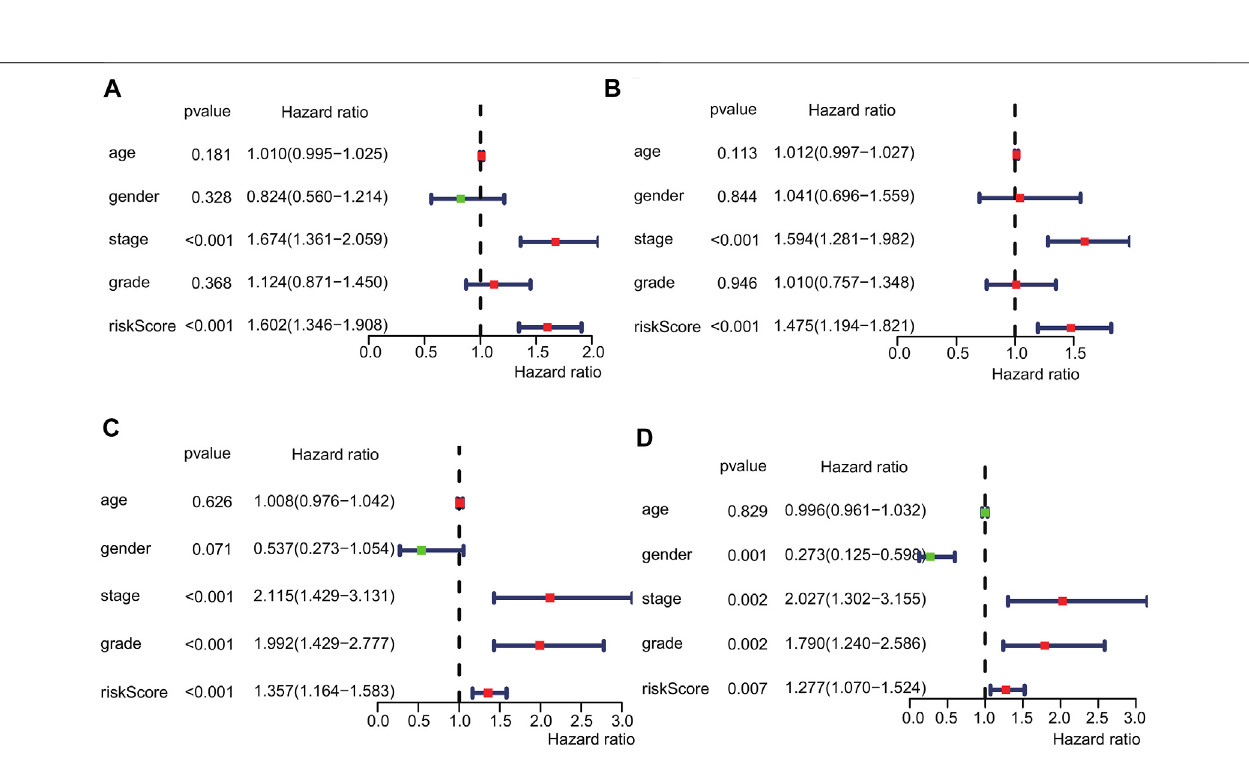
Frontiers in Genetics |